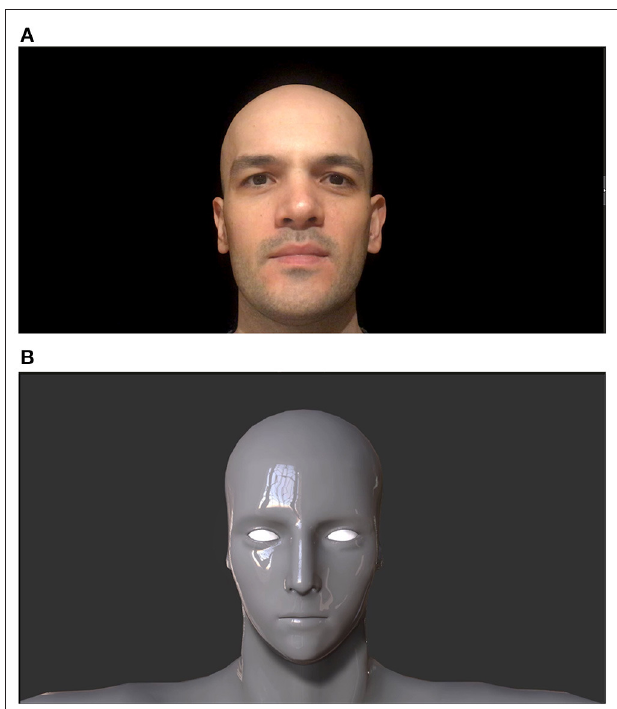
FIGURE 1 | Human (A) and robot faces (B) . Adapted from Mutlu et al. (2020).